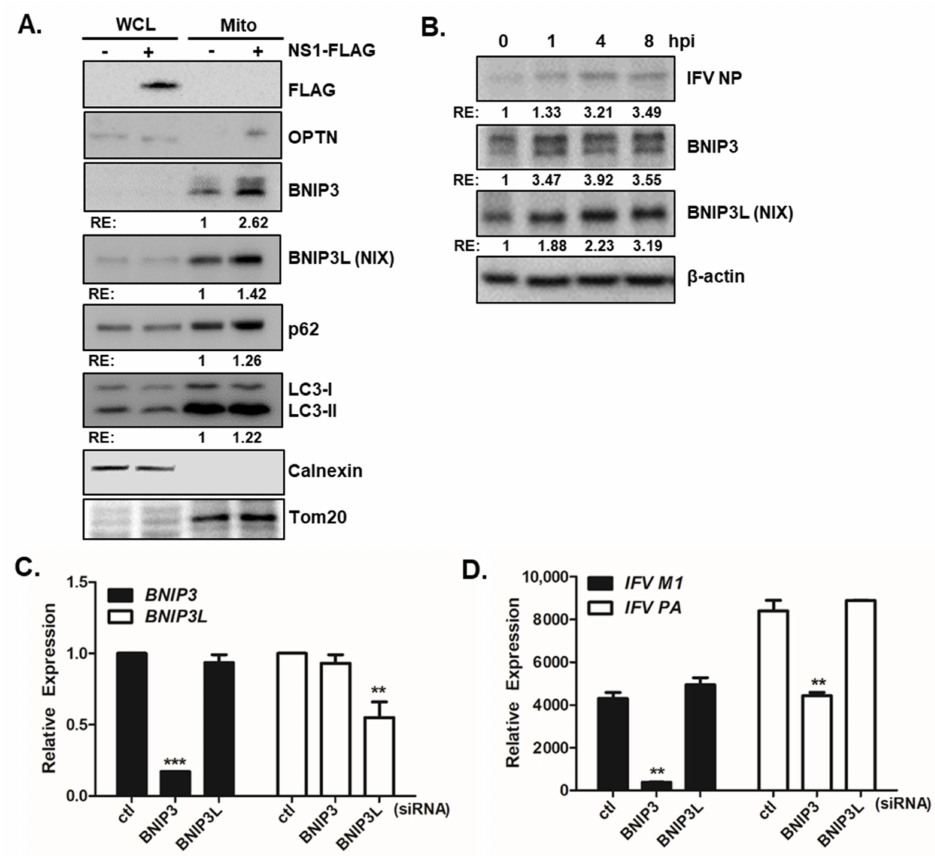
Figure 5. IFV NS1 upregulates mitochondrial BNIP3 expression, which is essential for viral replica- tion. ( A ) Immunoblot analysis shows whole-cell lysates (WCL) and mitochondrial fractions (Mito) derived from A549 cells transfected with either empty vector ( − ) or NS1-FLAG (+) plasmids. The relative band intensities were calculated using ImageJ software and are shown as numbers in the column. ( B ) A549 cells were infected with PR8 virus at an MOI of 1 for the indicated times. Protein expression levels of BNIP3 and BNIP3L were determined by immunoblot analysis. A representative of three independent experiments are shown. ( C , D ) A549 cells transfected with either control or BNIP3 or BNIP3L siRNA were infected with PR8 virus at a multiplicity of infection (MOI) of 1 for the indicated time periods. qRT-PCR results indicated the expression levels of BNIP3 , BNIP3L , IFV M1 and IFV PA . ** p < 0.01; *** p < 0.001 vs. the control siRNA-transfected